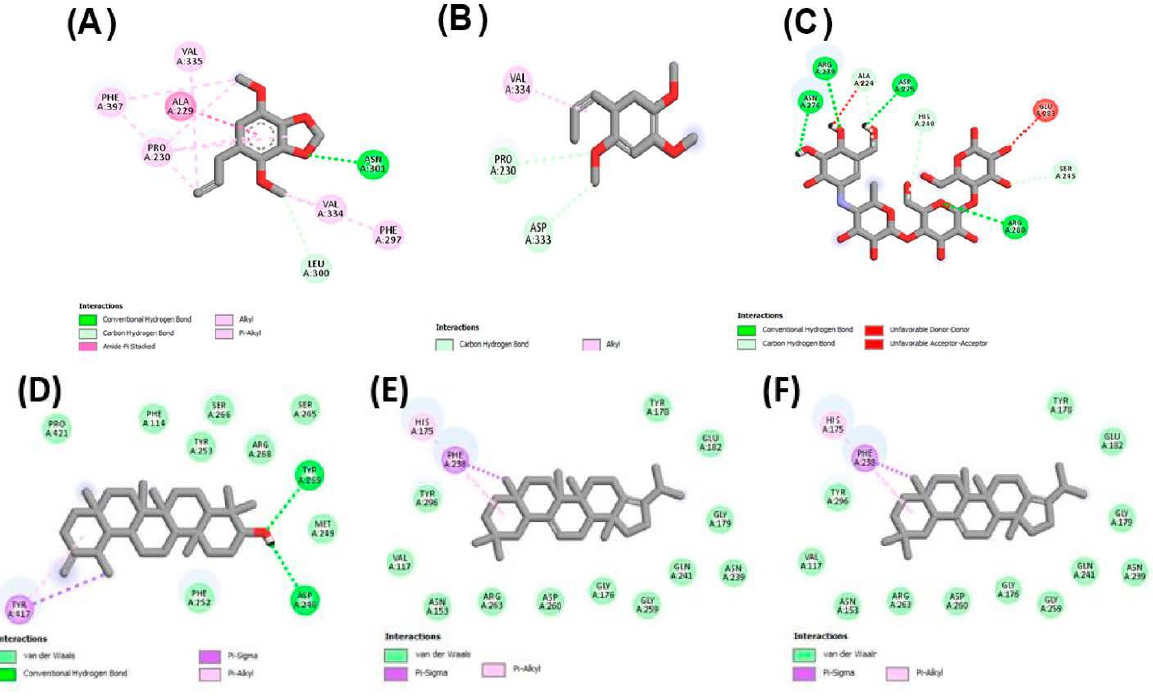
Figure 6. Interactions of residues of α -glucosidase active site (2D presentation) with ( A ) apiol, ( B ) asarone, ( C ) acarbose, ( D ) taraxasterol, ( E ) hopa-22(29)-ene-3alpha-ol, ( F ) a-neooleana-3(5), 12-dien.